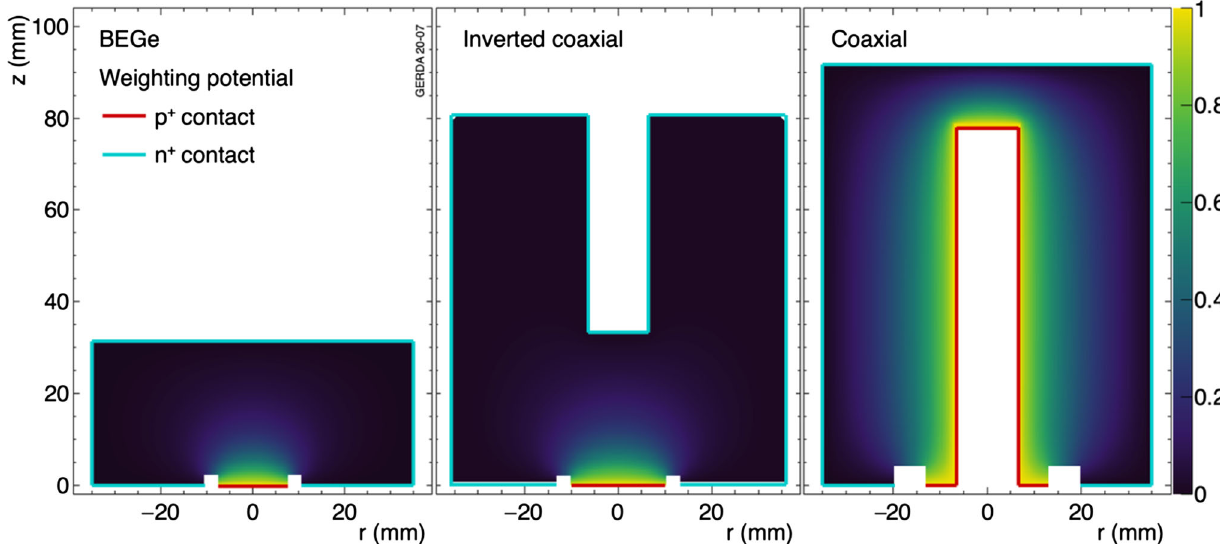
Fig. 1 Geometry and weighting potential of a typical BEGe, an inverted coaxial and a coaxial detector. The p + and n + contacts are indicated schematically